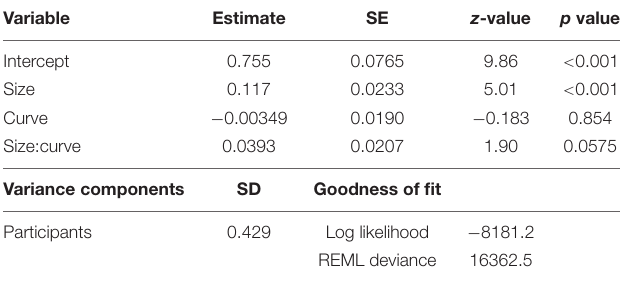
TABLE 1 | Effects of behavioral outcomes.